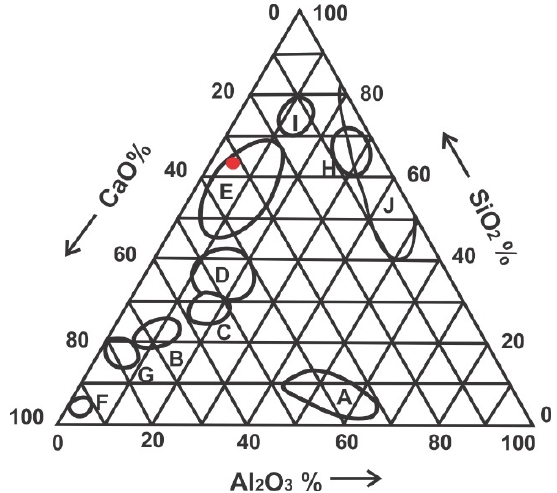
Figure 10. Position of the investigated slag (red dot) in the ternary diagram of binders and additives zones [42]. Note: A—aluminous cement; B—Portland cement; C—cement with slag; D—basic slag; E—acid slag; F—quicklime; G—hydrated lime; H—trass (pozzolan); I—silicate substances; J—pozzolans (natural and artificial).